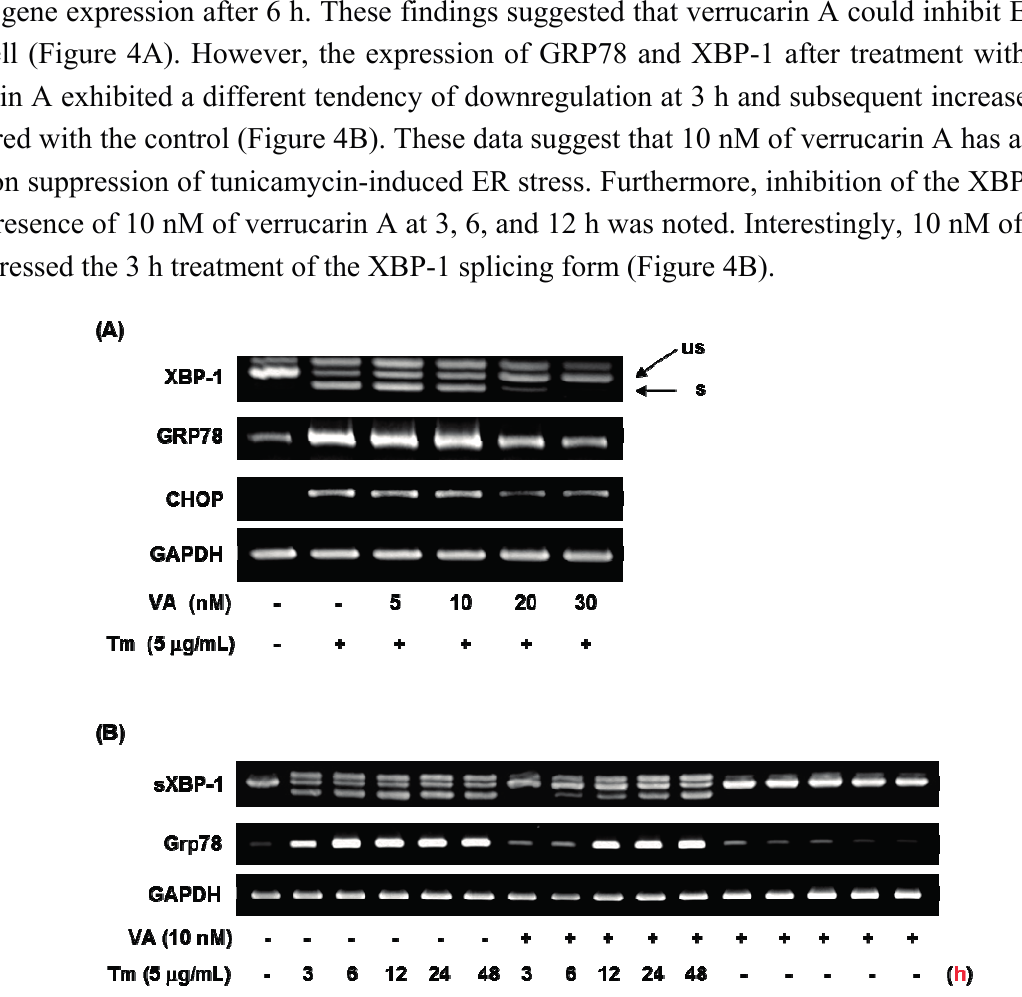
Figure 4. Verrucarin A inhibits ER stress in FaO cells. ( A , B ) RT-PCR analysis. Tunicamycin (Tm)-induced XBP-1 splicing, GRP78 and CHOP gene expression were inhibited by verrucarin A. Cells pre-treated with verrucarin A at concentrations of 0, 5, 10, 20, and 30 nM or not with each dose for 1 h were exposed to 5 μ g·mL − 1 Tm for 6 h in FaO cells. The arrows represent the unspliced form (us) and spliced form (s) of XBP-1. (+): treated with Tm, ( − ): untreated